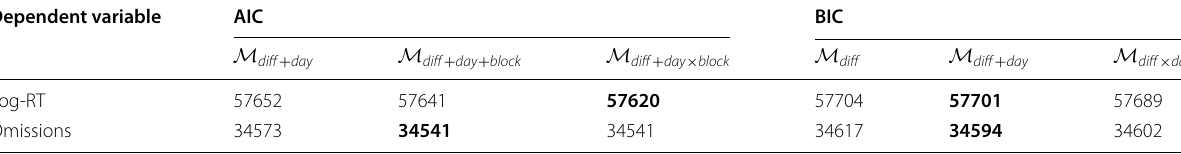
Table 4 Results of model comparison for effect of block on DRT